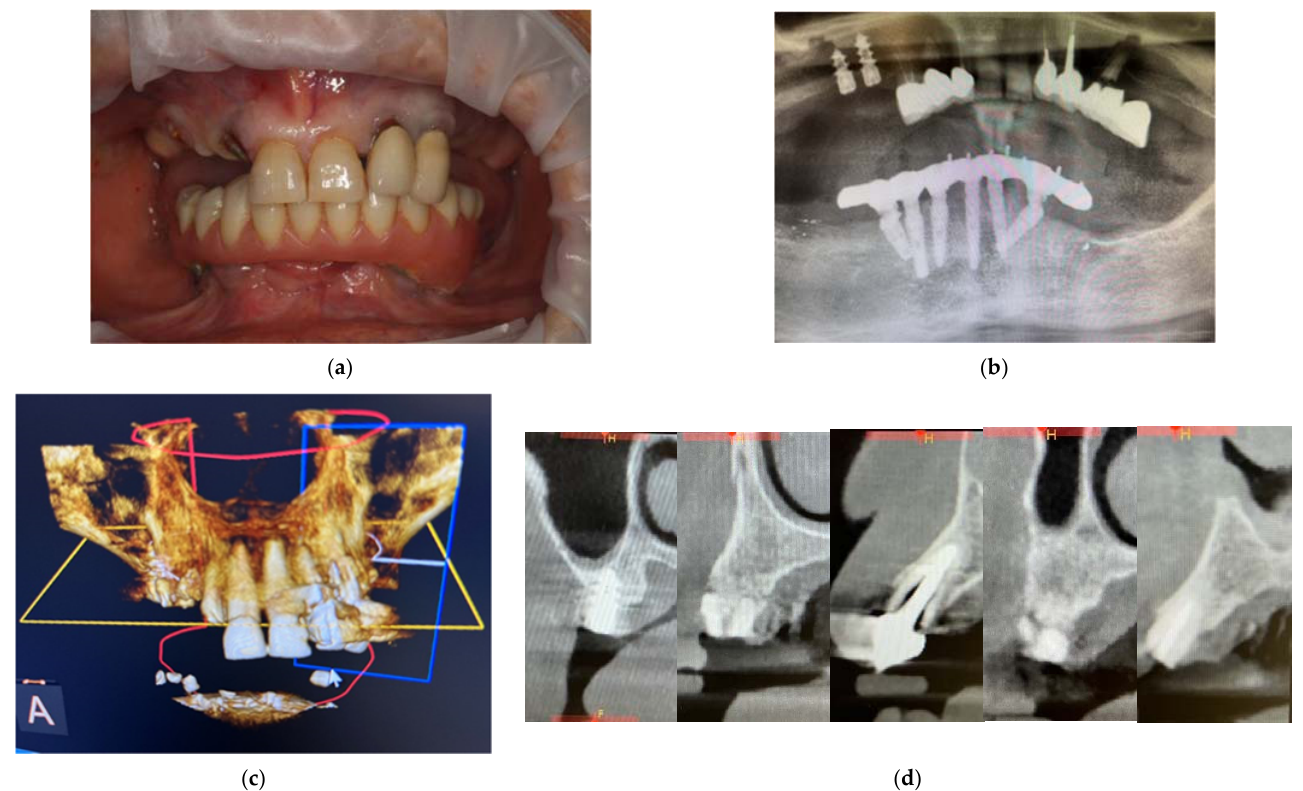
Figure 4. Intraoral photos of the patient ( a ) and orthopantomography ( b ) and CBCT 3D reconstruction ( c ) and cross sections ( d ).